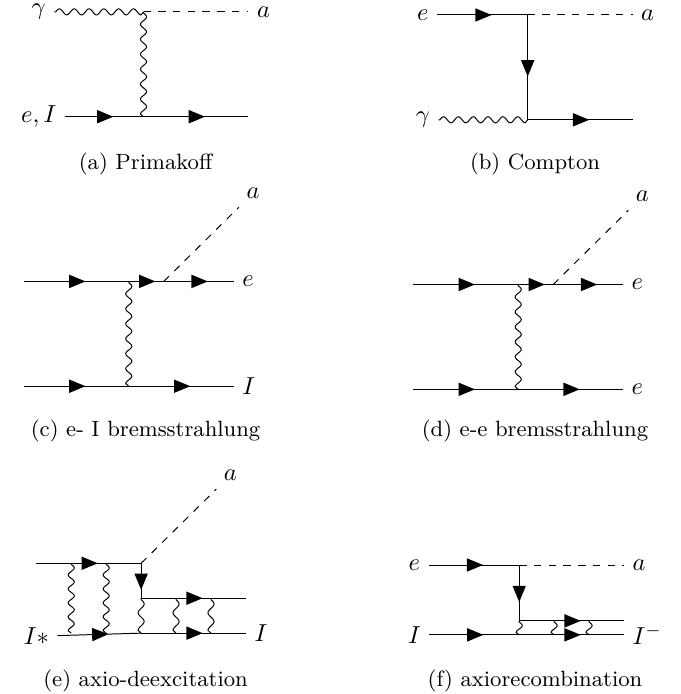
Figure 1. Feynman diagrams of the different processes responsible for axion production in the sun. The Primakoff conversion of photons in the electromagnetic fields of the solar plasma is proportional to g 2 a γ , and it is present at almost any axion model. In non-hadronic models, such as DFSZ (Dine- Fischler-Srednicki-Zhitnitsky) non-negligible couplings to electrons open up new channels, such as atomic axio-deexcitation and axio-recombination, axio-Bremsstrahlung in electron-ion or electron- electron collisions, and Compton scattering with axion emission. Those additional channels are usually referred to as the ABC solar axion flux, the flux being proportional to g 2 ae